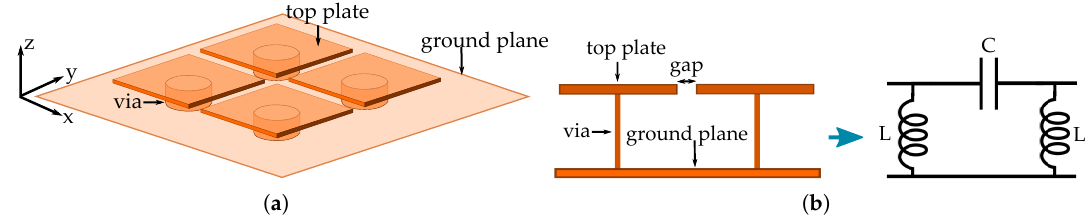
Figure 1. Sievenpiper mushroom-like metasurface. ( a ) Structure and components. ( b ) Equivalent circuit.